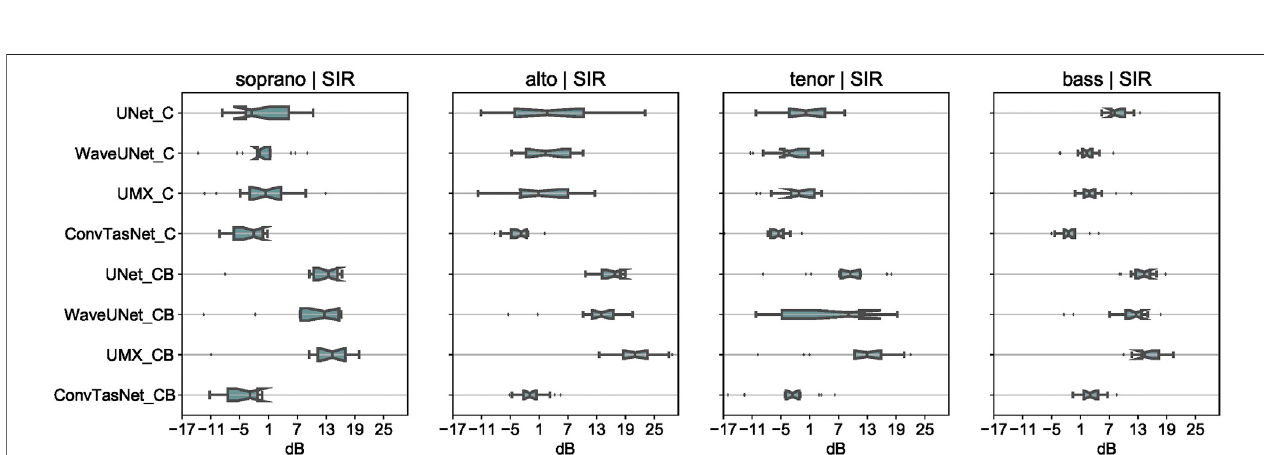
FIGURE 4 | Boxplot SIR results for the Choir case models trained on CSD ( modelname C ) and CSD + BCD ( modelname CB ).